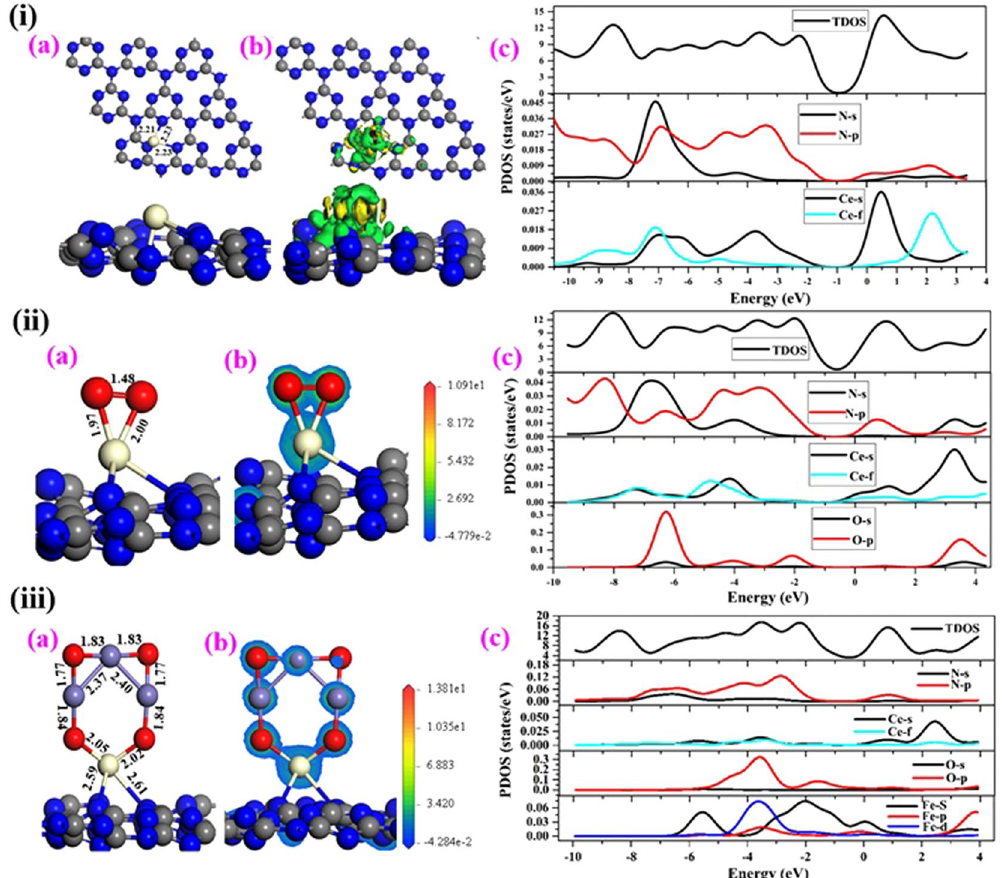
Figure 8. (i) Single Ce atom, (ii) CeO 2 and (iii) Fe 3 O 4 doped on graphitic carbon nitride (g/C 3 N 4 ) monolayer. ( a ) Optimized geometry. ( b ) Charge density differences, for the contour plots, the charge accumulation regions are rendered in green. The contour value of the charge difference density is ± 0.05 a.u. and ( c ) The spin- polarized partial density of states (PDOS) projected on TDOS (black), C-2 s (black) and C-2 p (red), N-2 s (black) and N-2 p (red) , Ce- 6 s (black) and Ce-4 f (cyan), O- 2s (black) and O-2 p (red) and Fe-4 s (black), Fe-4 p (red) and Fe-3 d (blue) states. The Fermi level is set to zero.